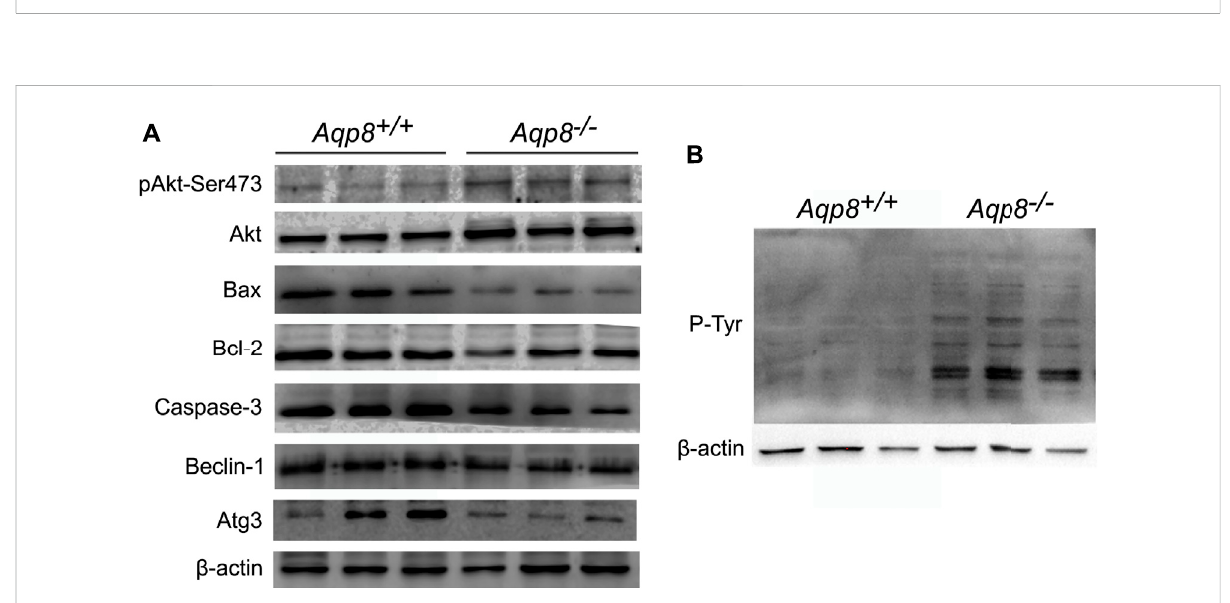
FIGURE 5 AQP8 inhibits pAktand phosphorylated tyrosine(P-Tyr)signaling. (A) Western blotdetection oftherelevant signaling pathway. (B) Westernblot of P-Tyr, which could be affected by H 2 O 2